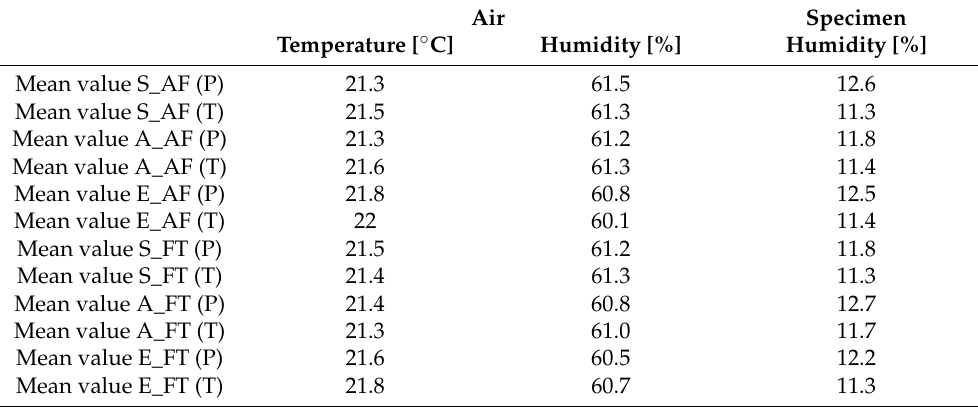
Figure 18. TGIB during four-point bending test.